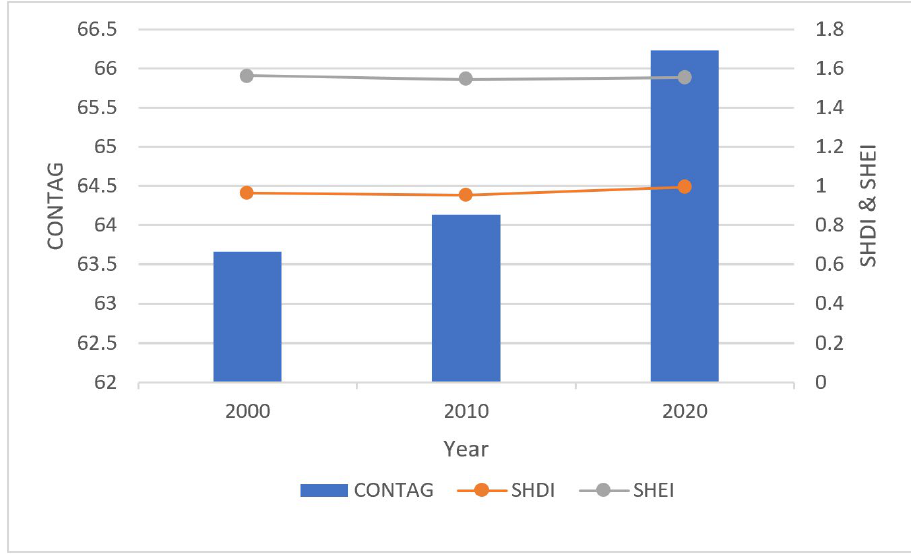
Figure 4. The change of SHDI, SHEI and CONTAG in the ECA of western Beijing during